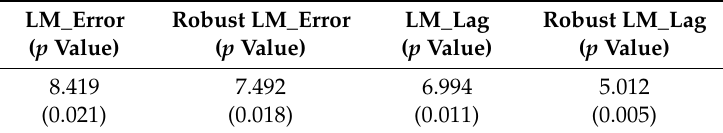
Table 9. Correlation estimation results of regional ITE convergence.